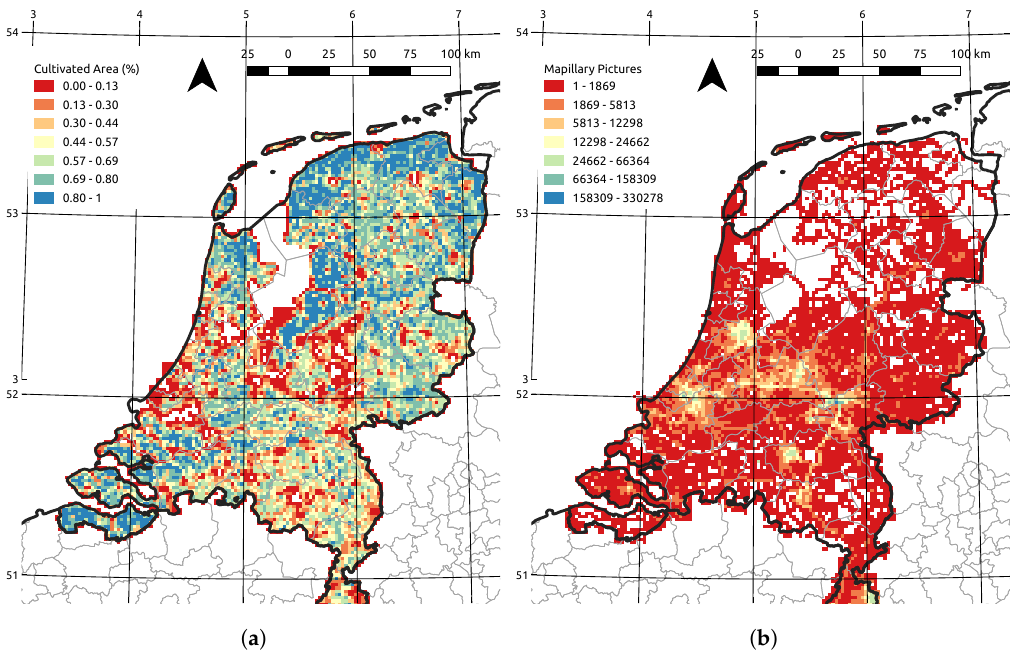
Figure 9. The proportion of agricultural land use in a 2 km grid over the Netherlands ( a ) shows the areas where data are needed for crop monitoring. The Mapillary data availability for agricultural parcels is aggregated for the same 2 km grid and shows a heterogeneous pattern ( b ).